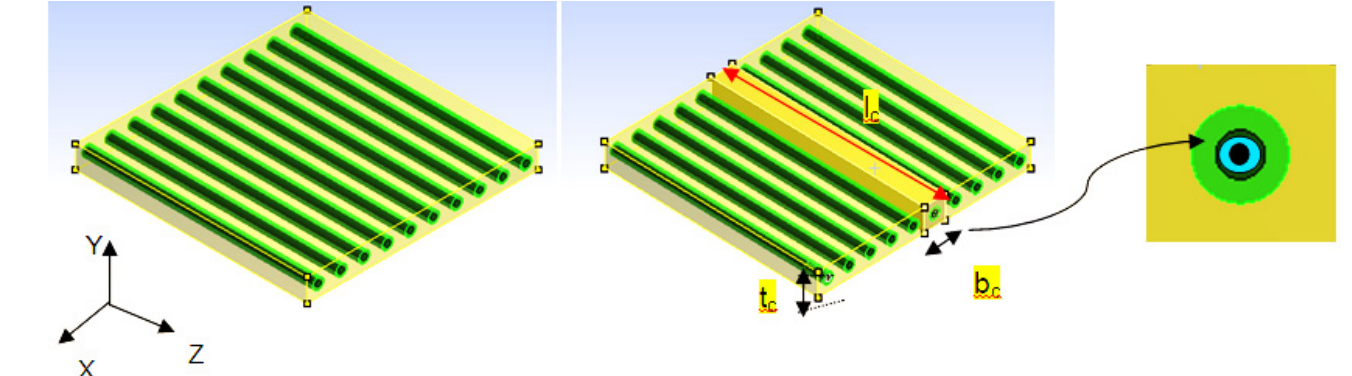
Figure 2. Idealization of natural fiber and selection of RVE with reference to the global coordinate system (X, Y and Z).